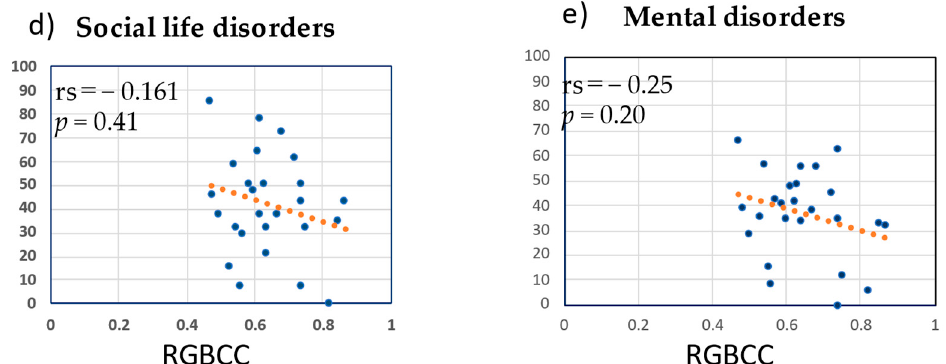
Figure 7. Correlations of red, green, and blue correlation coefficient (RGBCC) with scores of the domains of Japanese Orthopedic Association Back Pain Evaluation Questionnaire. ( a ) RGBCC versus score of pain-related disorders, ( b ) RGBCC versus score of lumbar function, ( c ) RGBCC versus score of gait disturbance, ( d ) RGBCC versus score of social life disorders, ( e ) RGBCC versus score of mental disorders.